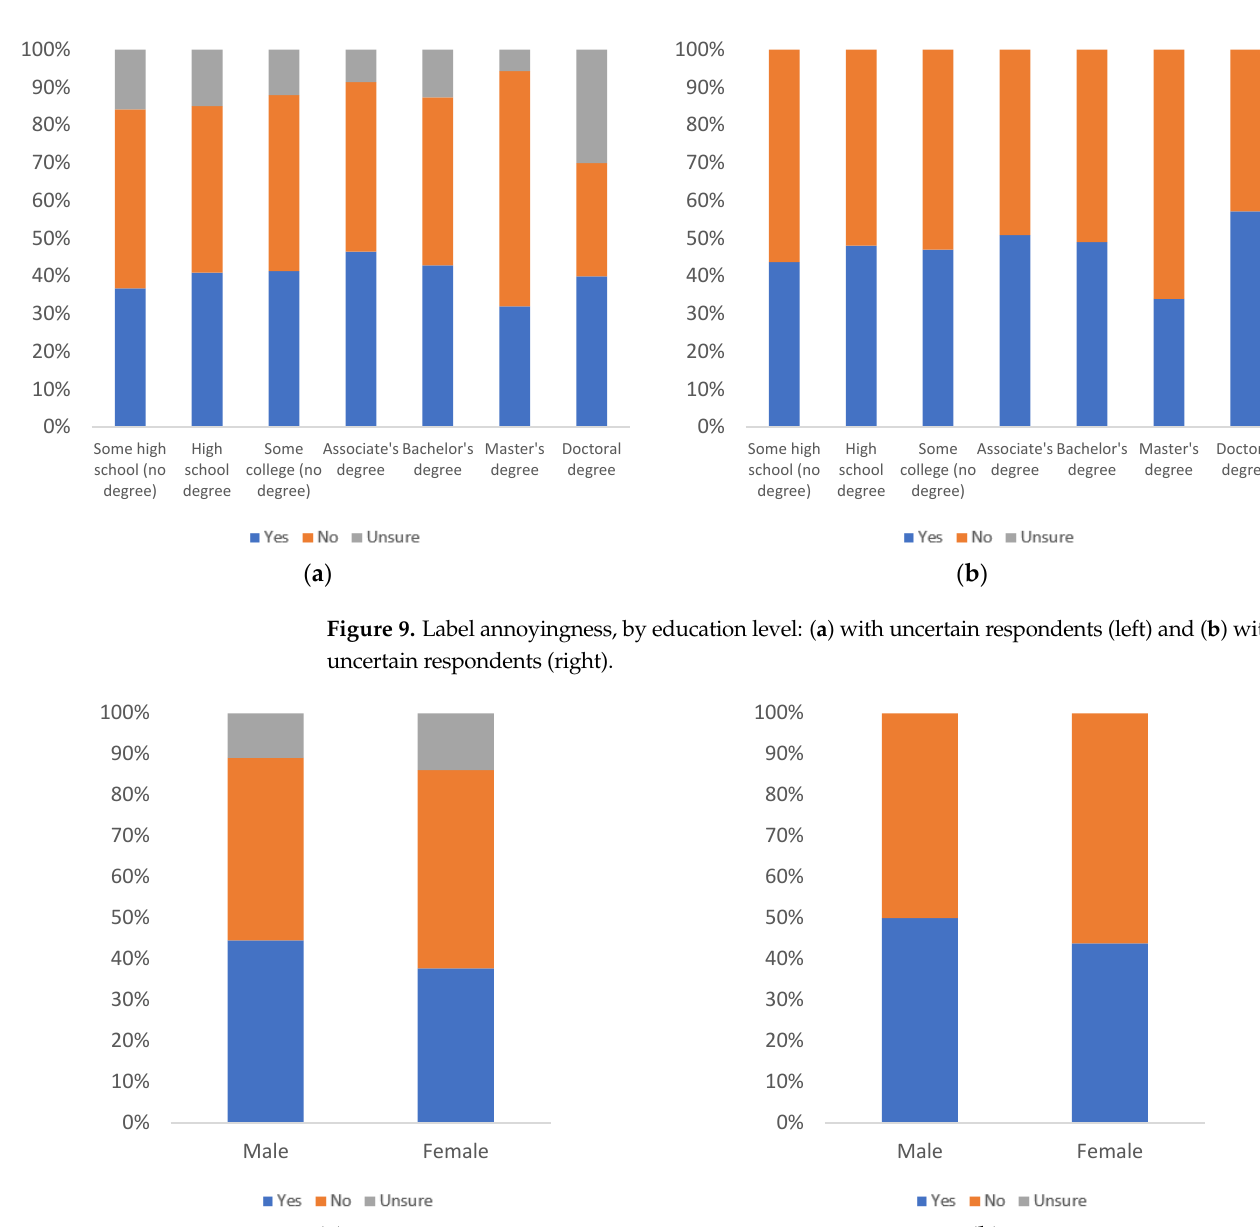
Figure 8. Label annoyingness, by age group: ( a ) with uncertain respondents (left) and ( b ) without uncertain respondents (right).